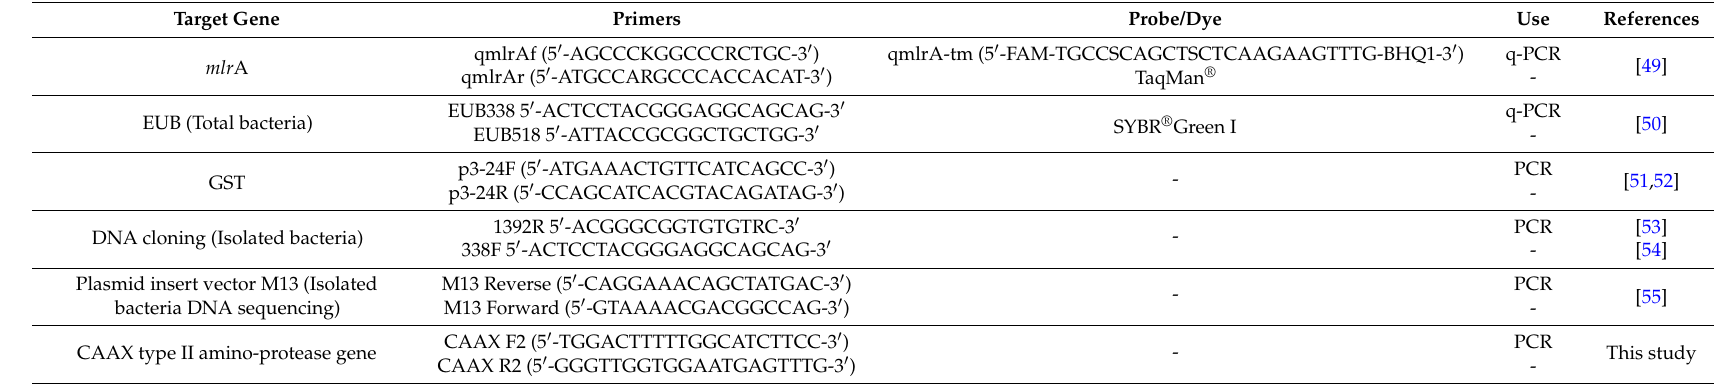
Table 1. List of primers and probe/dye used in the current